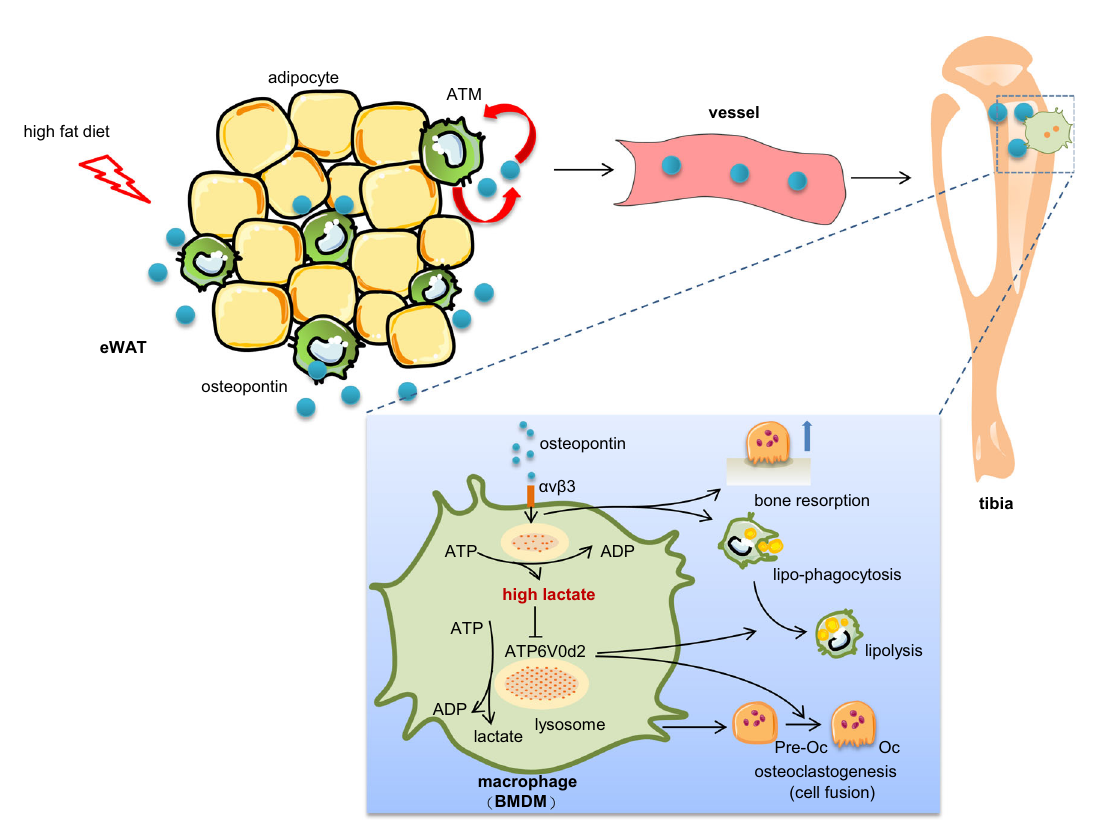
Fig. 10 Schematic diagram showing that macrophages in epididymal adipose tissue secrete OPN to regulate bone homeostasis. eWAT-secreted OPN accumulates in the bone marrow compartment where OPN promotes bone resorption and lipophagocytic mobilization, but the excess accumulation of lactate inhibits pre-osteoclast fusion and neutral lipid hydrolysis via lysosomal-dependent ATP6V0d2 in